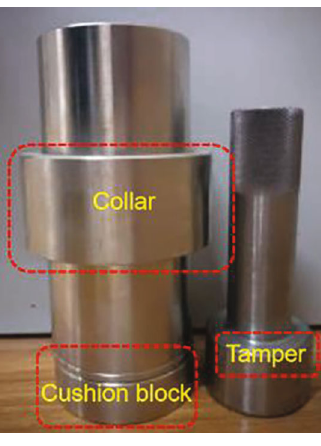
Figure 2: New test